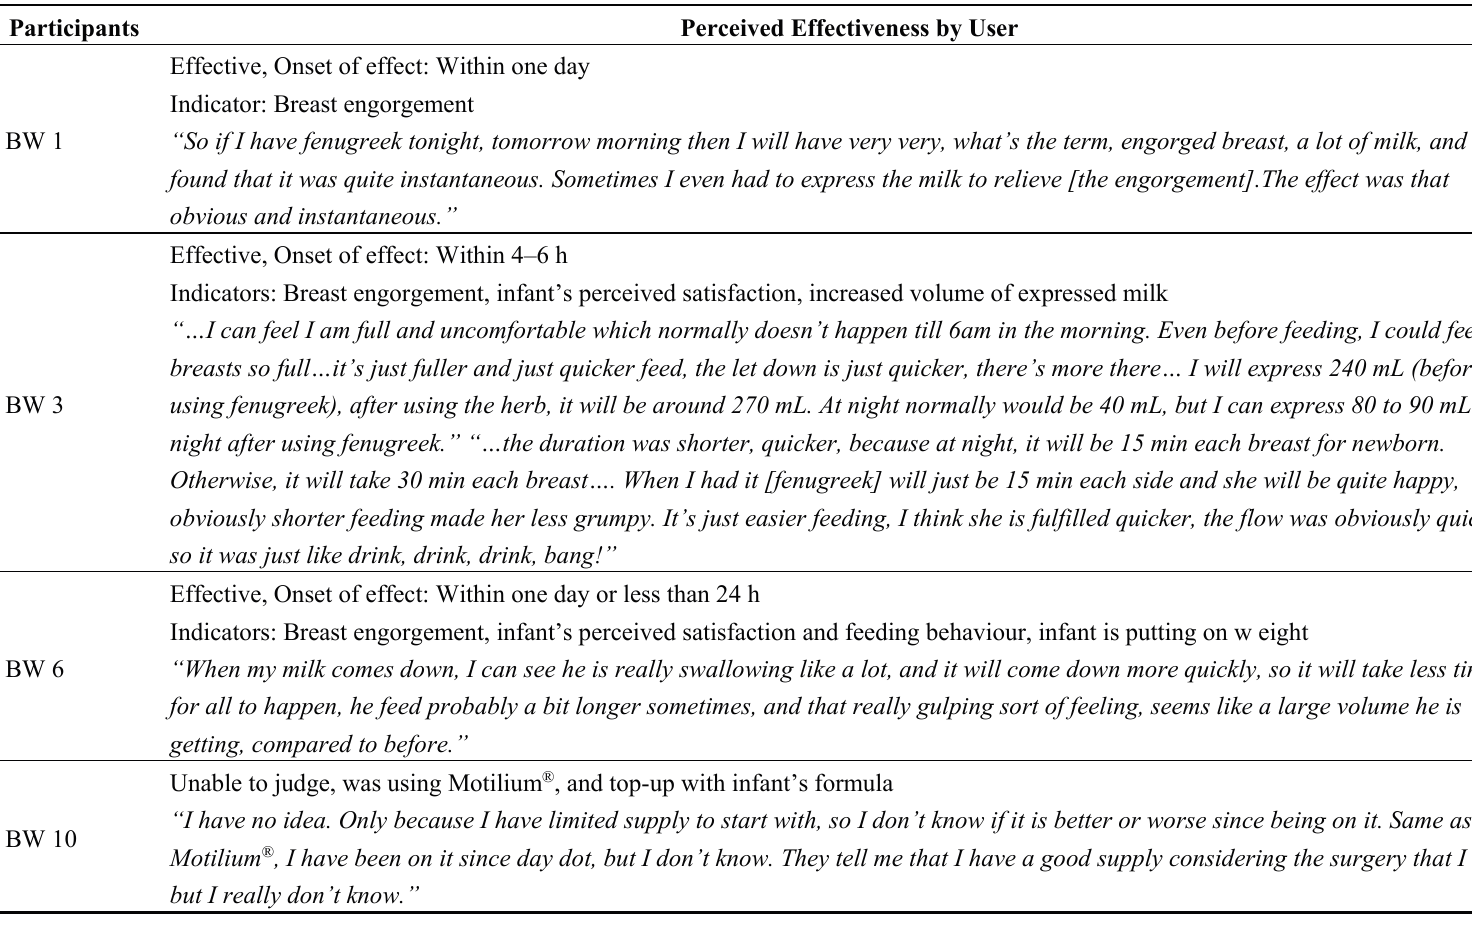
Table 4. Perceived effectiveness and safety: fenugreek as a sole